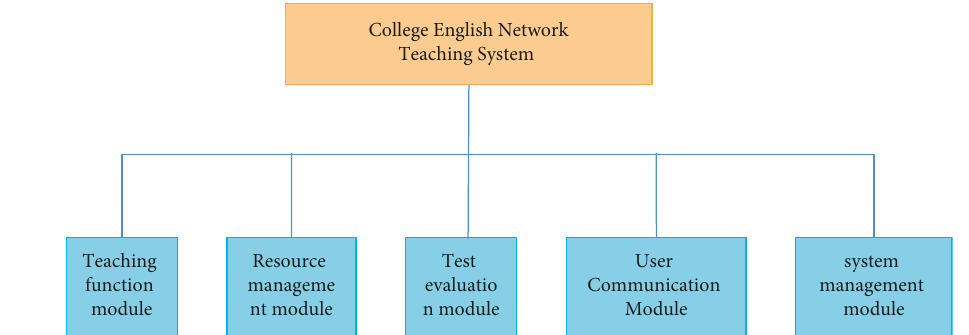
Figure 2: Functional module diagram of network-assisted instruction system.